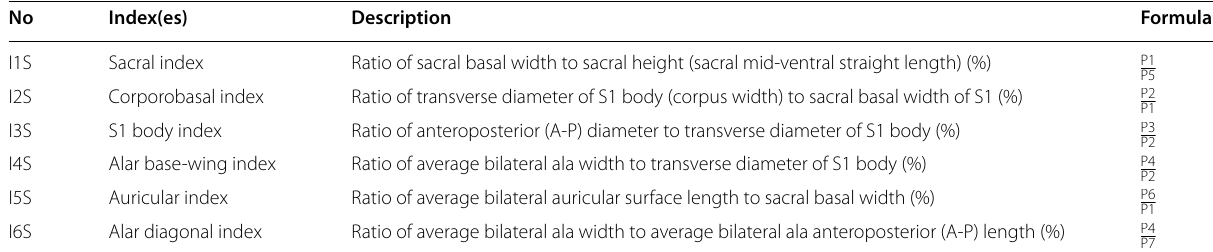
Table 3 Definition and description of sacrum indexes adopted from Kanika et al. (2011) and Shreekrishna et al. (2013)